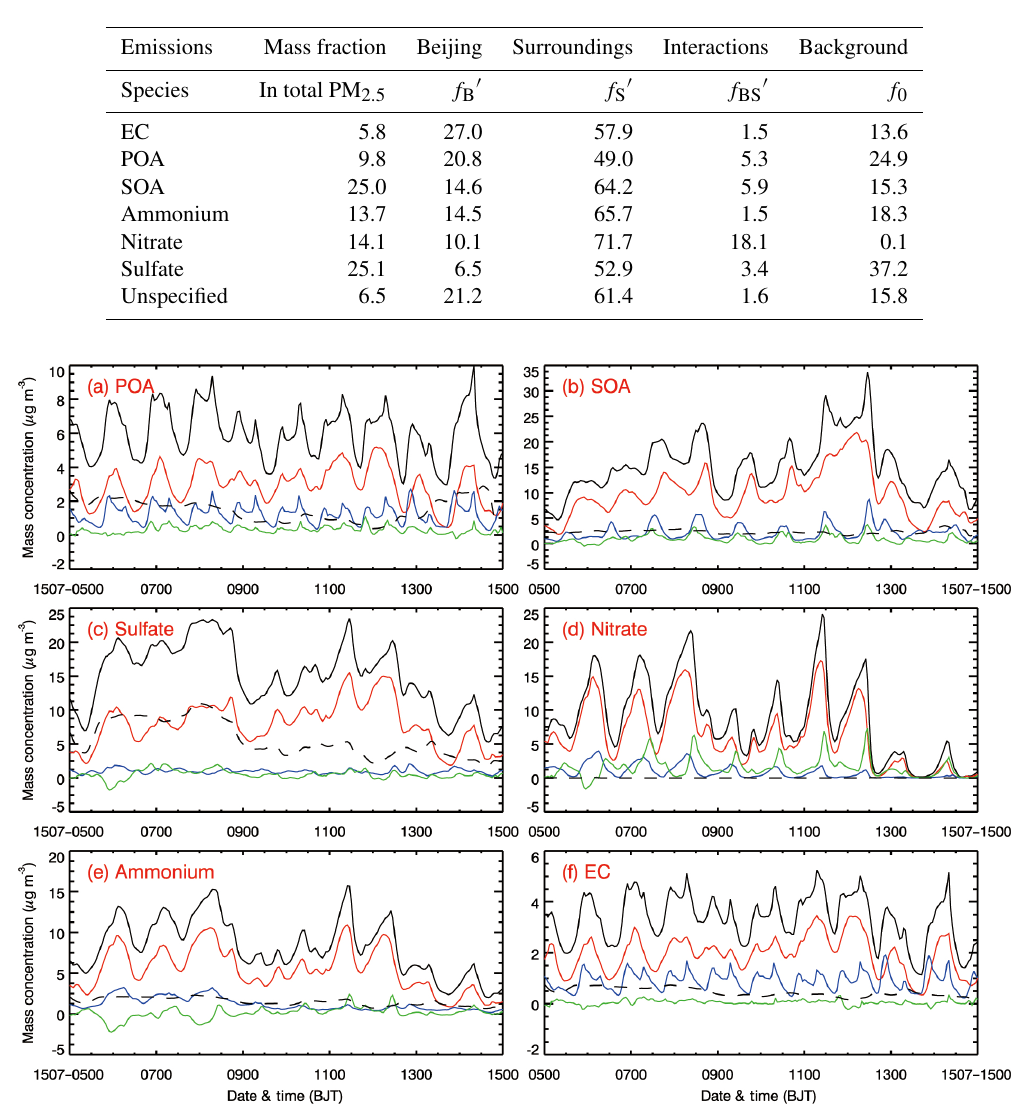
Table 5. Aerosol species’ contributions (%) from local emissions, non-Beijing emissions, interactions of both emissions, and background, as well as mass fraction in the total PM 2 . 5 (%) in Beijing averaged during the period from 5 to 14 July 2015.